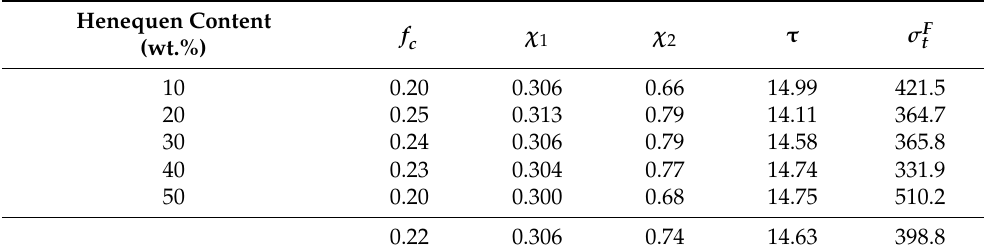
Table 5. Evolution of the coupling factor, orientation factor, length and interface factor, interface shear strength, and intrinsic tensile strength of henequen